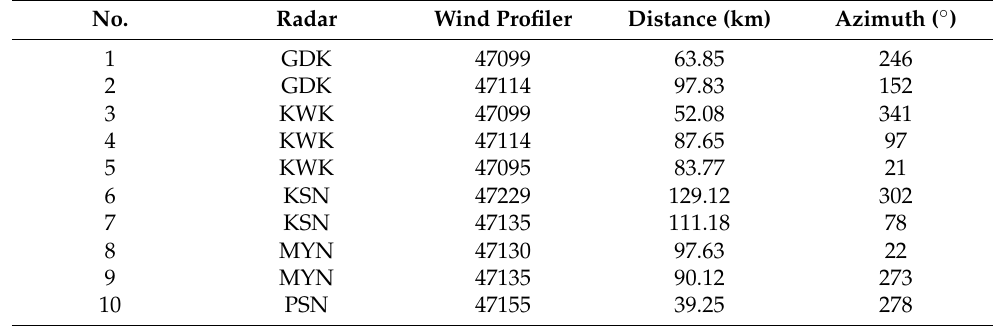
Figure 14. ( left ) Conceptual diagram of geometrical matching for radial velocity comparison be- tween radar and wind profilers and ( right ) deployment of weather radars and wind profilers in Korea. Table 2. Distance and azimuth of the wind profilers from the radars used for verification.